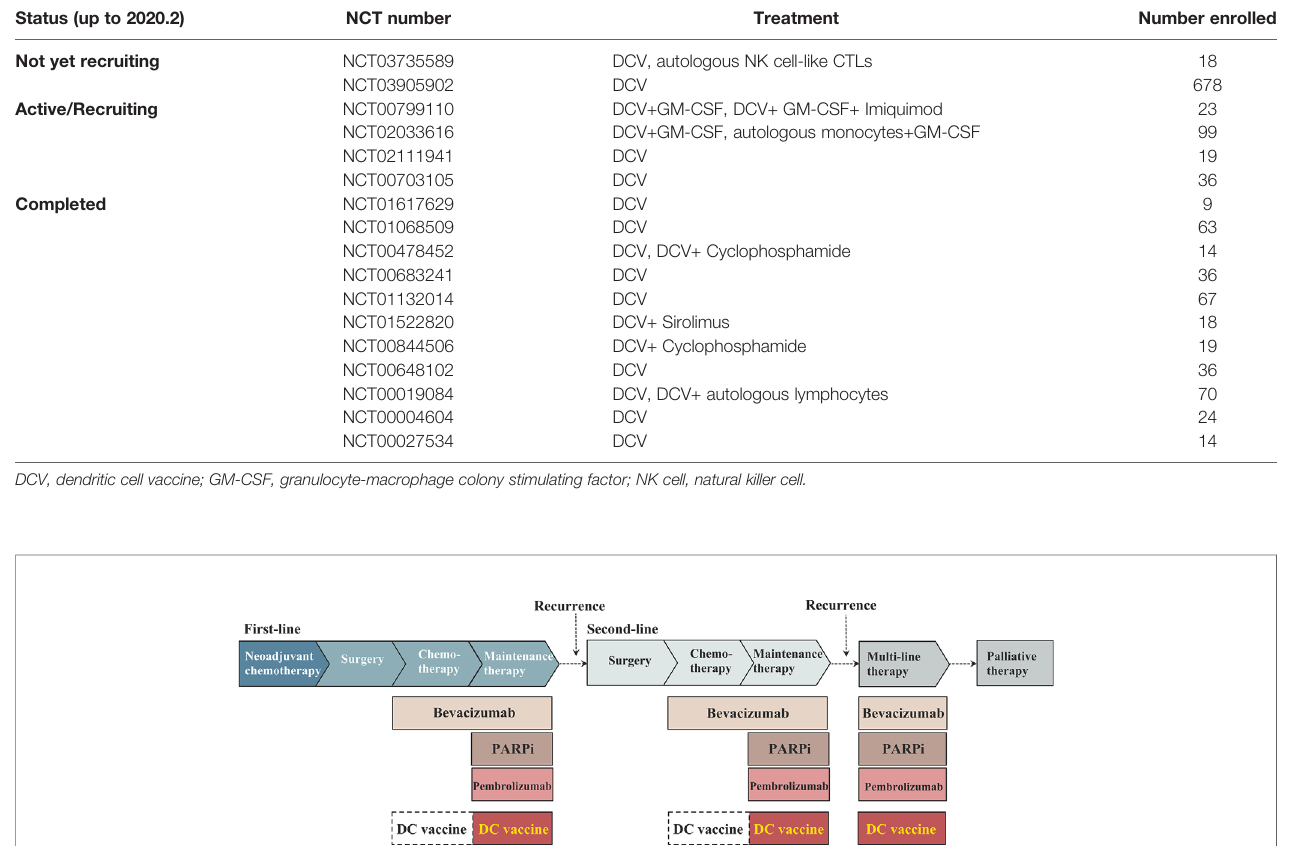
TABLE 3 | Clinical trials of dendritic cell (DC) vaccine in ovarian cancer registered on